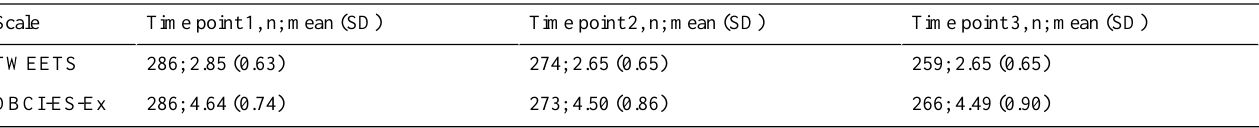
Table 2. Descriptive statistics for the TWente Engagement with Ehealth Technologies Scale (TWEETS) and the experiential subscale of the Digital Behavior Change Intervention Engagement Scale (DBCI-ES-Ex) at different time